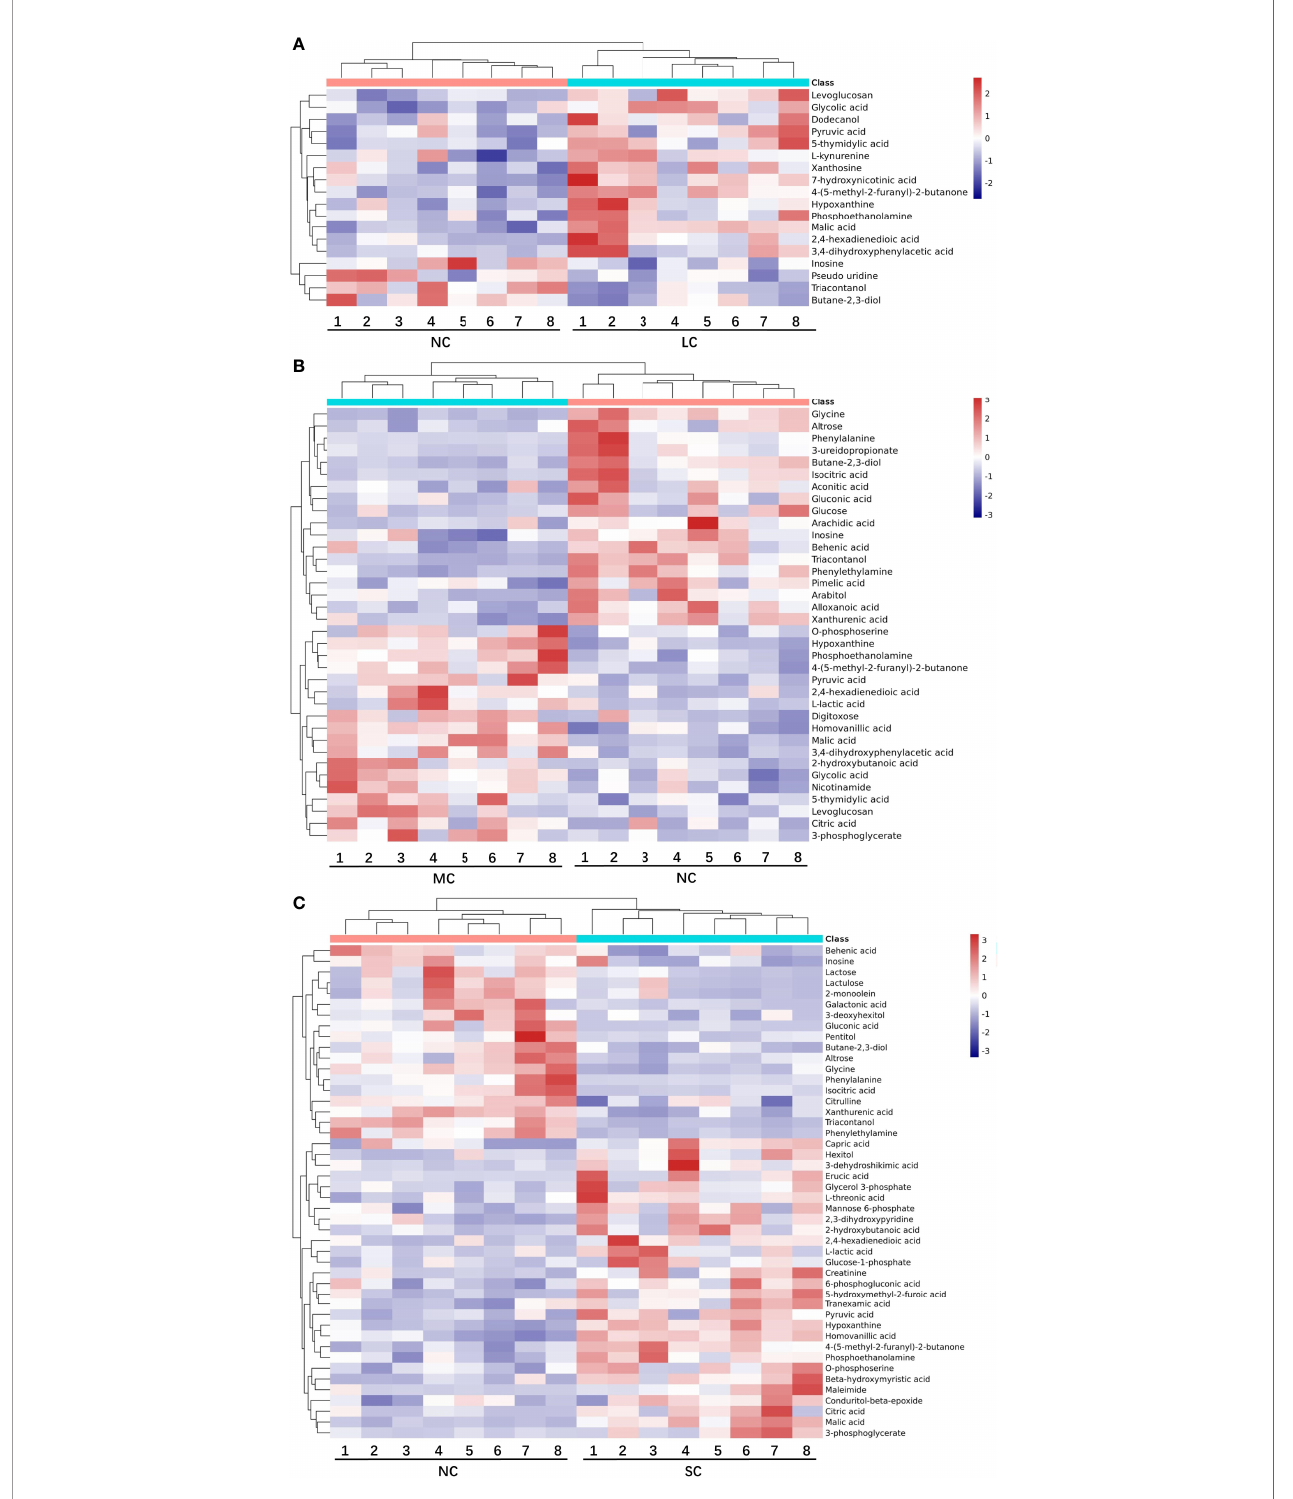
FIGURE 3 | Heat map of differential metabolites in LCvsNC group (A) , MCvsNC group (B) , SCvsNC group (C) . Each gill sample is visualized in a column, and each metabolite is represented by a row. Blue indicates a lower metabolite concentration, while red indicates a higher metabolite level (refer to color